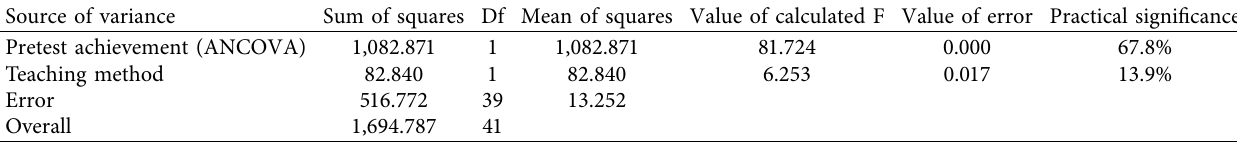
Table 3: Results of the one-way analysis of variance